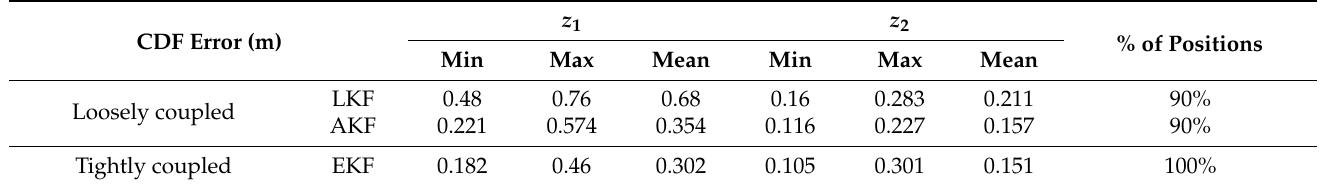
Table 13. Summary of the CDF errors for 90% of the estimated positions and the availability of estimates at z 1 and z 2 . CDF Error